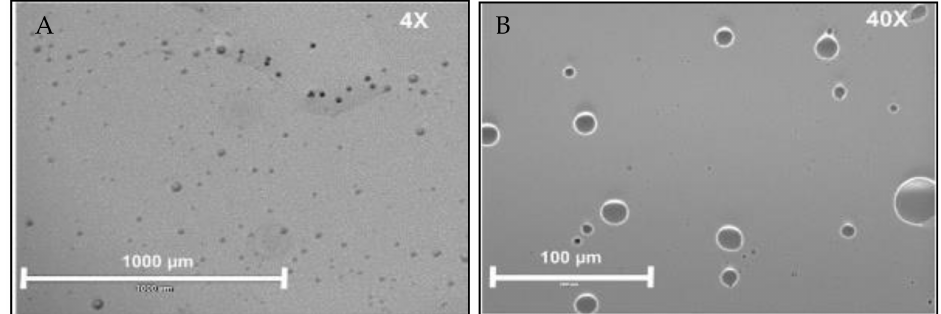
Figure 2. Light microscopy images of the gelatin microspheres.